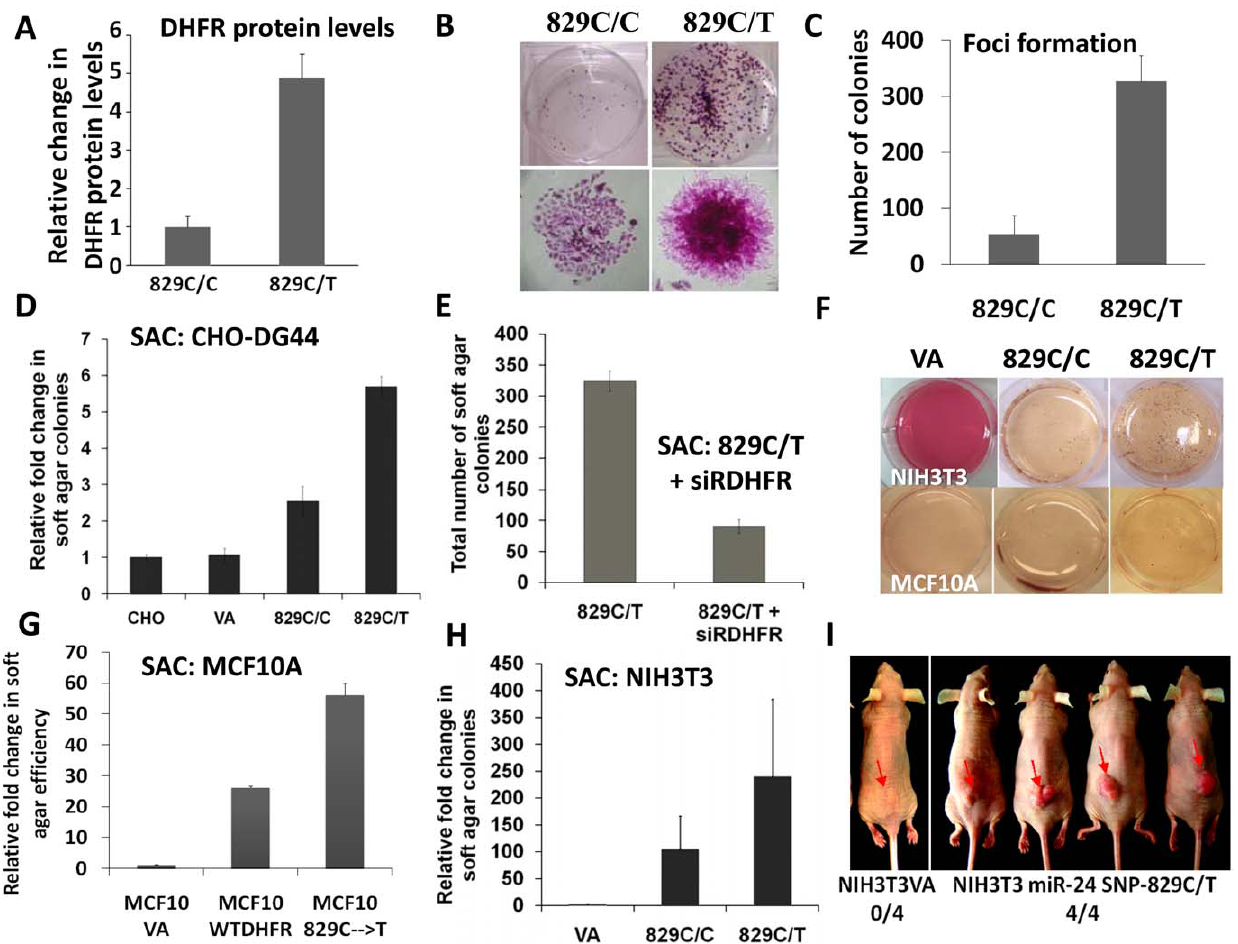
Figure 5. A loss-of-function miR-24 target site SNP contributes to cellular transformation. (A) The miR-24-TS-SNP (829C R T) expressing CHO-DG44 cells over-expressed DHFR [22]. (B–C) DHFR over expression in CHO-DG44 cells due a loss of miR-24 function results in an increase in colony forming ability and (D) show anchorage-independent growth in semi solid agar as compared to vector alone expressing cells (p-value . 0.05) (Soft agar colony-forming assay is abbreviated as SAC). (E) Transfection of a siRNA specific to DHFR reduced the ability of miR-24-TS-SNP expressing cells to form soft agar colonies by threefold. (F-H) miR-24-TS-SNP expression in a human cell line - MCF10A (G) and two rodent cell lines - NIH3T3 (H) and RK3 (see Table S1) resulted in more soft agar colony formation as compared to the cells expressing the vector alone and DHFR with wt 3 9 UTR. (I) DHFR overexpression due to the miR-24-TS-SNP renders NIH3T3 cells tumorigenic when transplanted in nude mice.